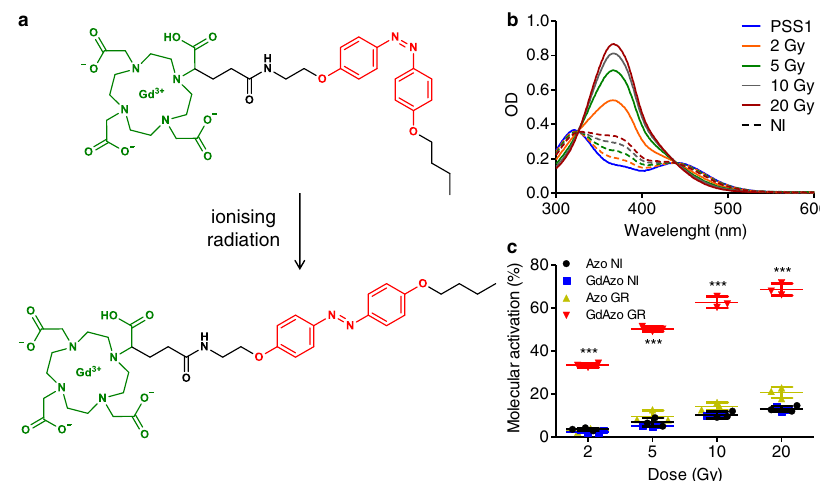
Fig. 2 Molecular activation upon IR. a Activation of cis - GdAzo (top) into trans - GdAzo (bottom) upon IR. b Absorbance spectra of cis - GdAzo compound (photostationary state 1, PSS1) recorded after GR irradiation at 2, 5, 10, and 20 Gy. The control absorbance spectra of non-irradiated (NI) cis - GdAzo compound analysed concurrently are drawn in dashed lines with corresponding color. c Molecular activation of cis - GdAzo and cis - Azo (control molecule without Gd atom) determined by HPLC and reported as the difference of trans -isomer proportion before and after GR irradiation ( n = 3 independent experiments). The means ± standard deviations are reported. Two-way Anova (Bonferroni post-test) was used for statistical analyses (All vs GdAzo GR, t -values = 20.78, 30.29, 34.99 and 37.43 for GdAzo NI vs GdAzo GR at doses 2, 5, 10, and 20 Gy). *** P < 0.001. OD optical